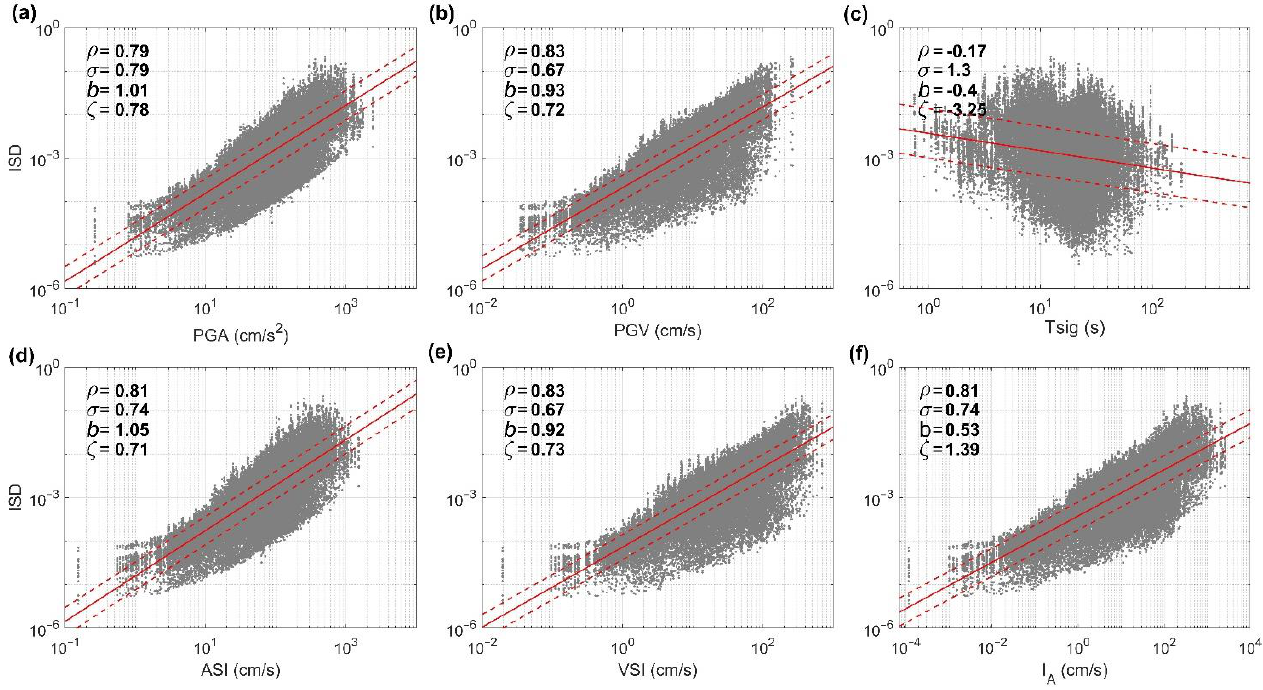
Figure 5. Correlation between inter-story drift ratio and six intensity measures. Bold numbers denote the correlation coefficient, efficiency, practicality, and proficiency of IMs with respect to equation log ( ∆ ) = a + b ∗ log ( IM ) (red line). Variability (sigma) is computed as the mean of residual ( δ ) from equation log ( ∆ ) = a + b ∗ log ( IM ) + δ . ( a , b ) correspond to peak measures ( PGA, PGV ) and ( d , e ) correspond to spectral measures ( ASI, VSI ). ( c , f ) are for significant duration ( T sig ) and Arias intensity ( I A ). Table 5. Correlation, efficiency, practicality, and proficiency of 15 IMs. IM Cordova , IM Vamvatsikos , IM Lin , IM Bianchini and IM Tsantaki are computed using Equations (2)–(5), (7) and (8), respectively. VSI , ASI , A RMS , I A and CAV are computed using Equations (10) and (11) and Equations